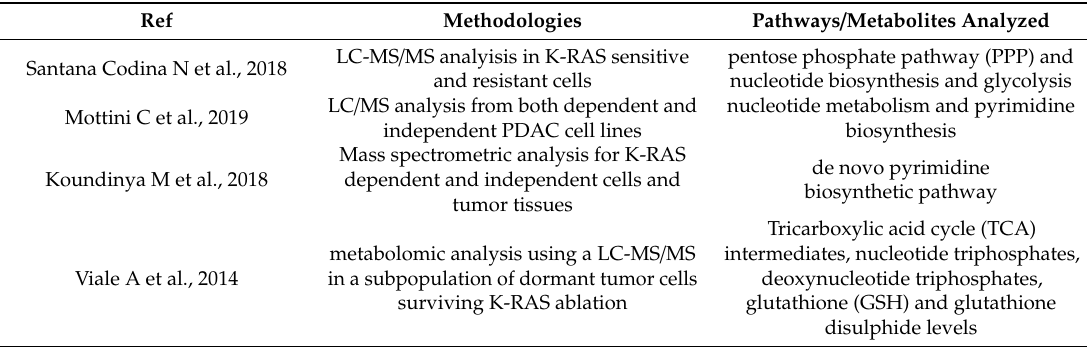
Table 2. Comparison of previously published metabolic profiles of K-RAS-dependent and independent pancreatic cancer cell lines and